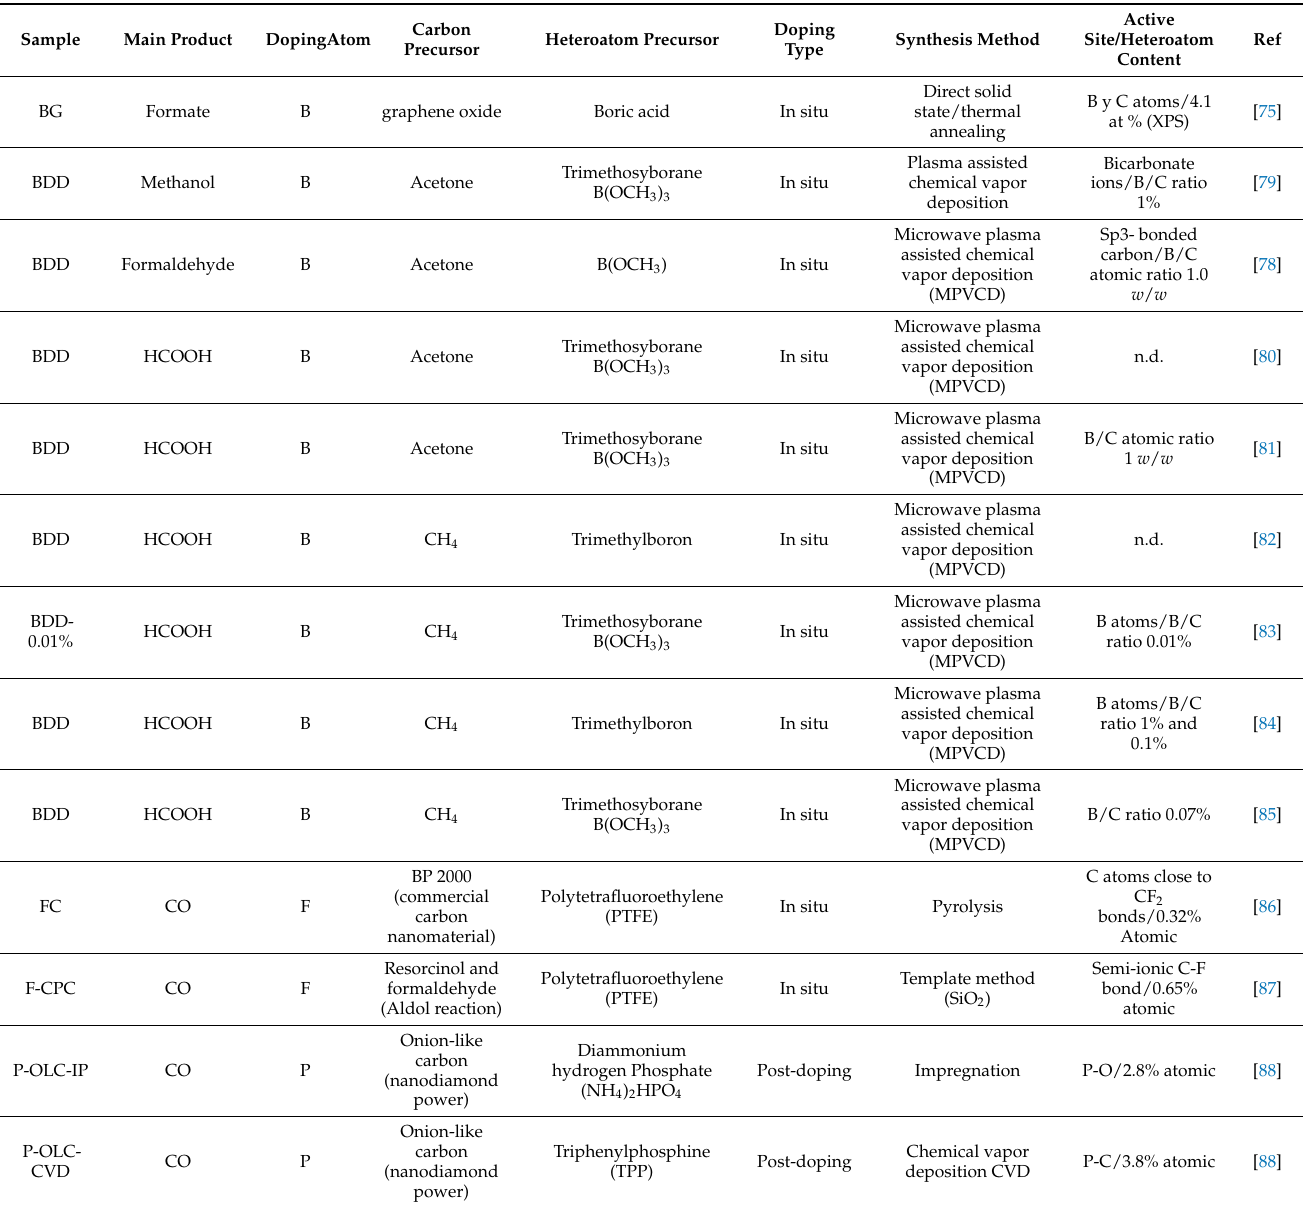
Table 4. Carbon and boron precursors to construction of electrocatalysts and active